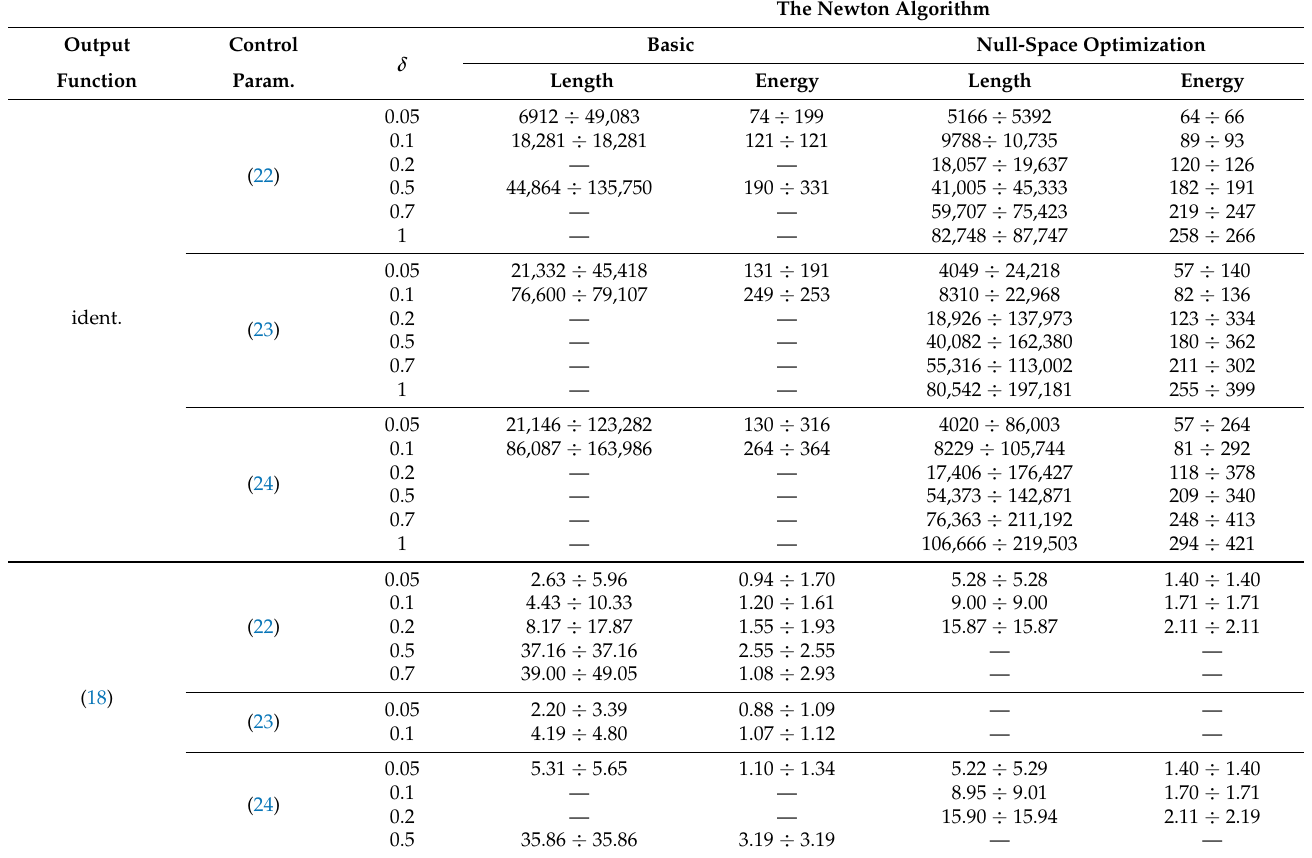
Table 5. Path length and energy of motion for the kinematic